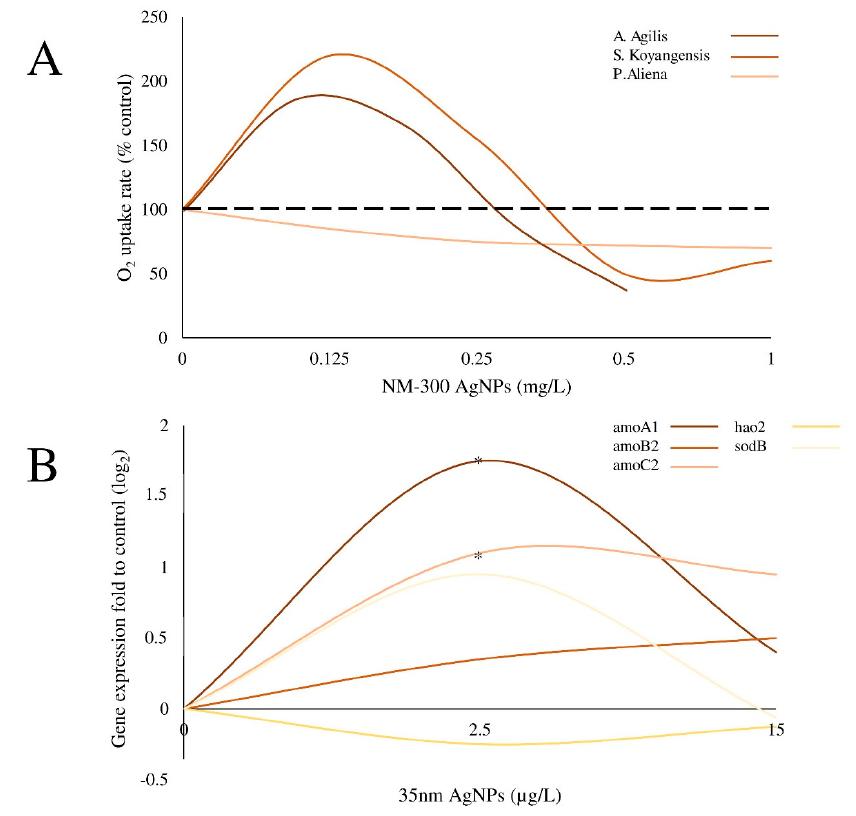
Figure 2. Examples of species-specific biphasic response observed in different bacteria. ( A ) The respirometry assays showed that NM-300 AgNPs were able to induce a hormetic response only in Gram-positive bacteria ( A. agilis and S. koyangensis ) (modified by Echavarri-Bravo et al. [18]). ( B ) The exposure of N. europaea to 35 nm AgNPs affected the transcriptional activity of nitrifying genes ( amoA1 , amoB2 , amoC2 , hao2 and sodB ) showing a biphasic response. This effect was not evident in other bacteria ( P. tutzeri and A. vinelandii ) (modified by Yang et al. [19]). * Indicates statistical significance ( p <